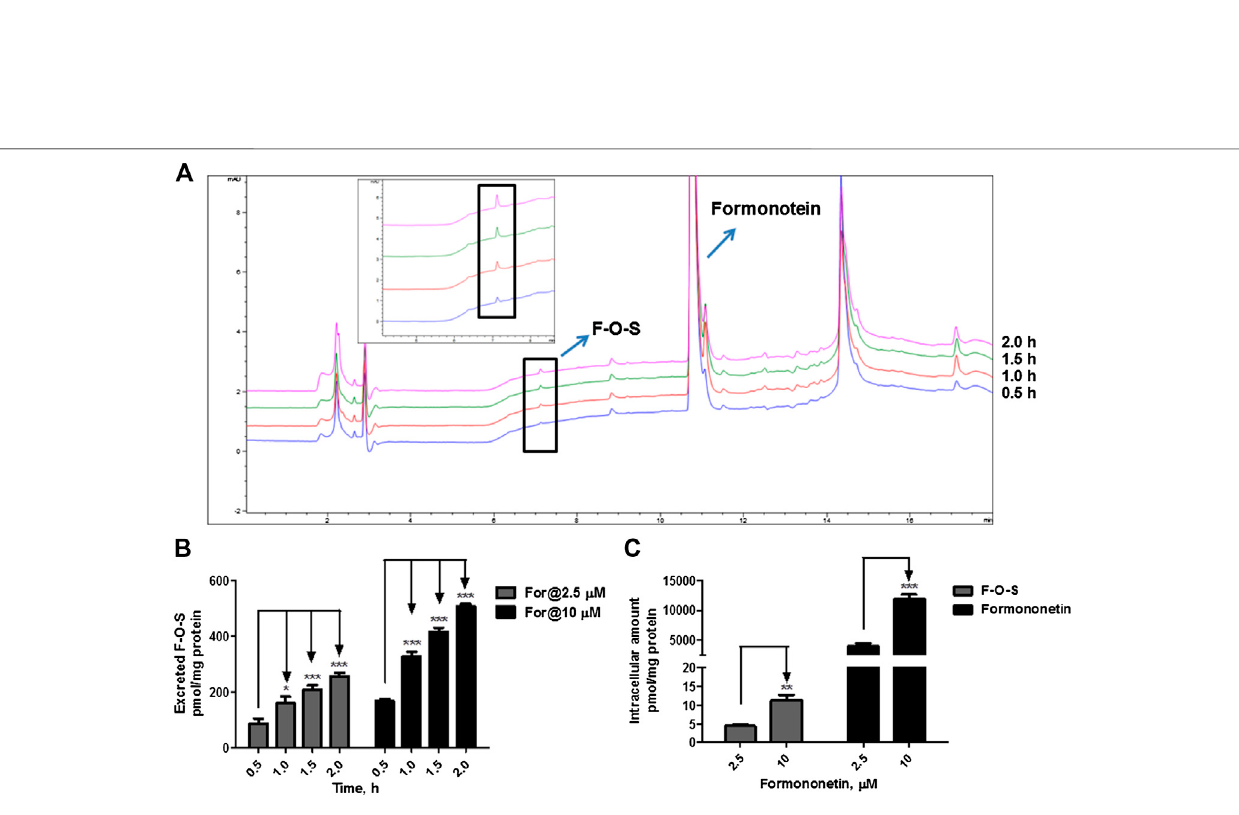
Frontiers in Pharmacology |